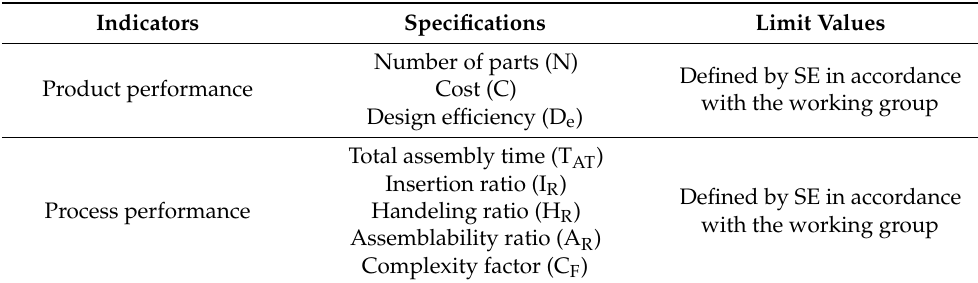
Table 1. Assemblability